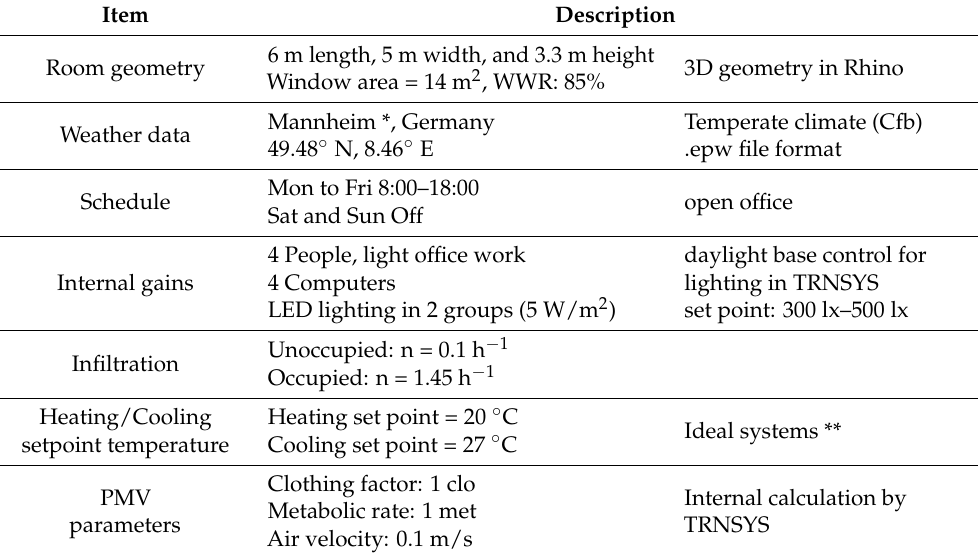
Table 3. Simulation setups in TRNSYS and model